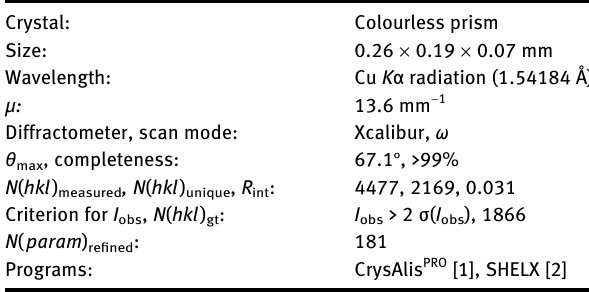
Table  : Data collection and